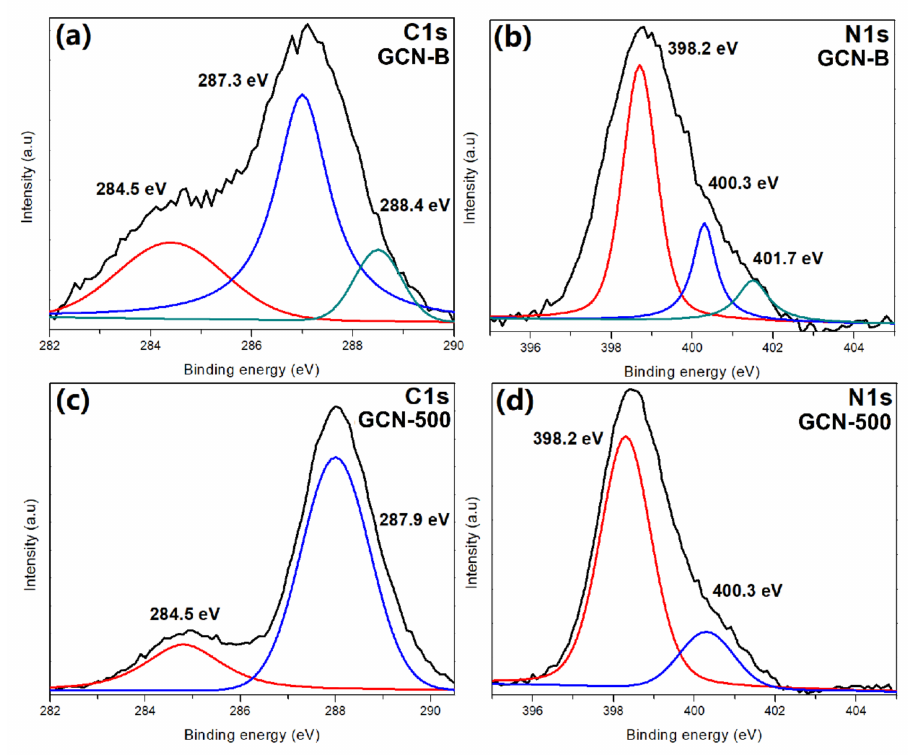
Figure 8. XPS spectra of GCN samples ( a ) C1s of GCN-B, ( b ) N1s of GCN-B, ( c ) C1s of GCN-500, ( d ) N1s of